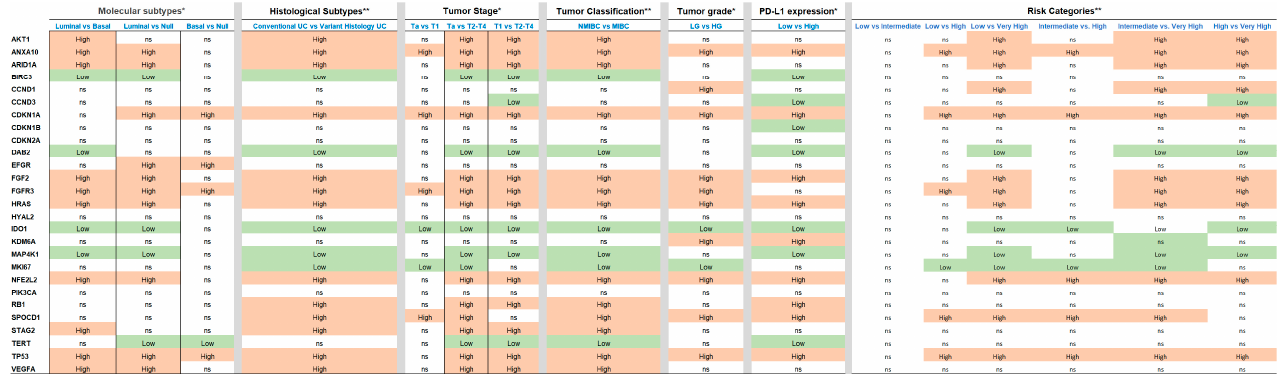
Figure 3. Statistical analysis based on t -test * or ANOVA ** showing associations of the genes differentially expressed with molecular, histological, and clinical subtypes of urothelial carcinoma and with tumor-stage category, tumor grade, PD-L1 expression or clinically meaningful risk categories (statistical signi fi cance based on false discovery rate p < 0.05).